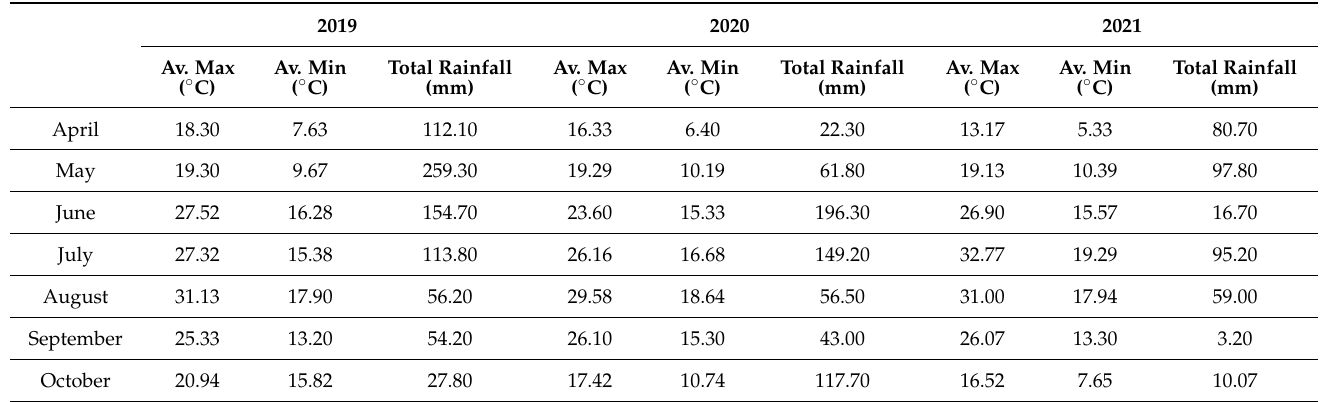
Table 1. Average monthly temperature and rainfall over three growing seasons (2019–2021):